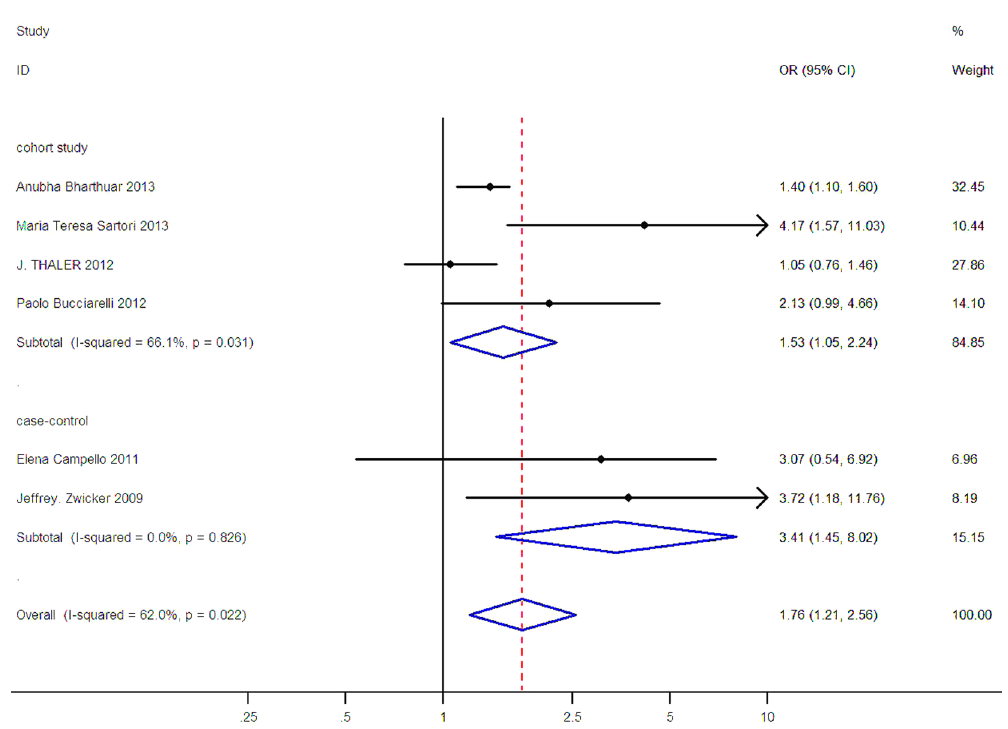
Figure 3. Subgroup analysis of association between TF-bearing MPs and VTE risk by study design, the horizontal lines represent the study-specific OR and 95% CI, respectively. The diamond indicates the summary results of OR with its corresponding 95%